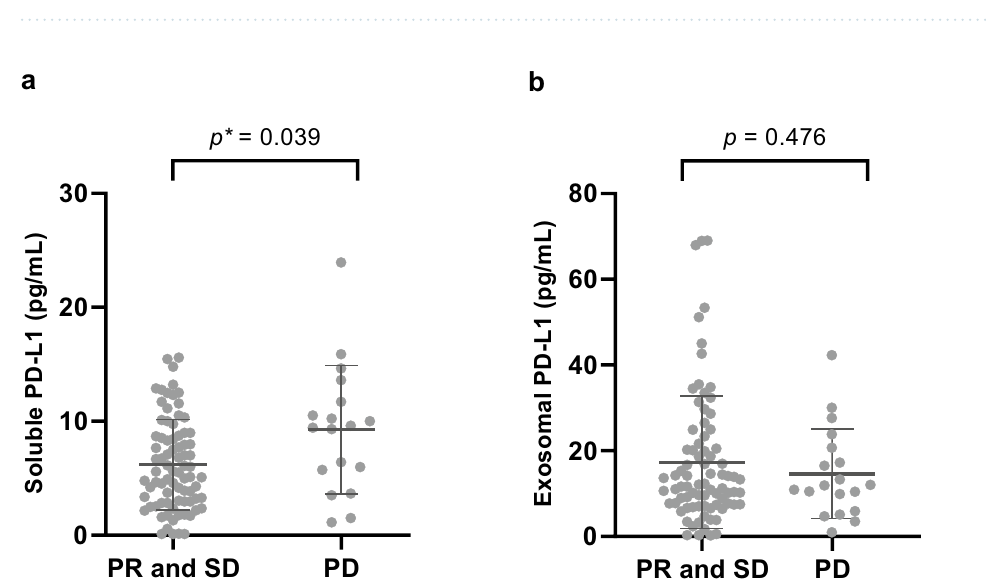
Figure 2. Level of exoPD-L1 and sPD-L1 according to clinical response ( a ) baseline sPD-L1 was significantly lower in partial response and stable disease (PR and SD) group than progressive disease (PD) group ( b ) the level of exoPD-L1 was not different between the groups. Unpaired t -test was performed between two